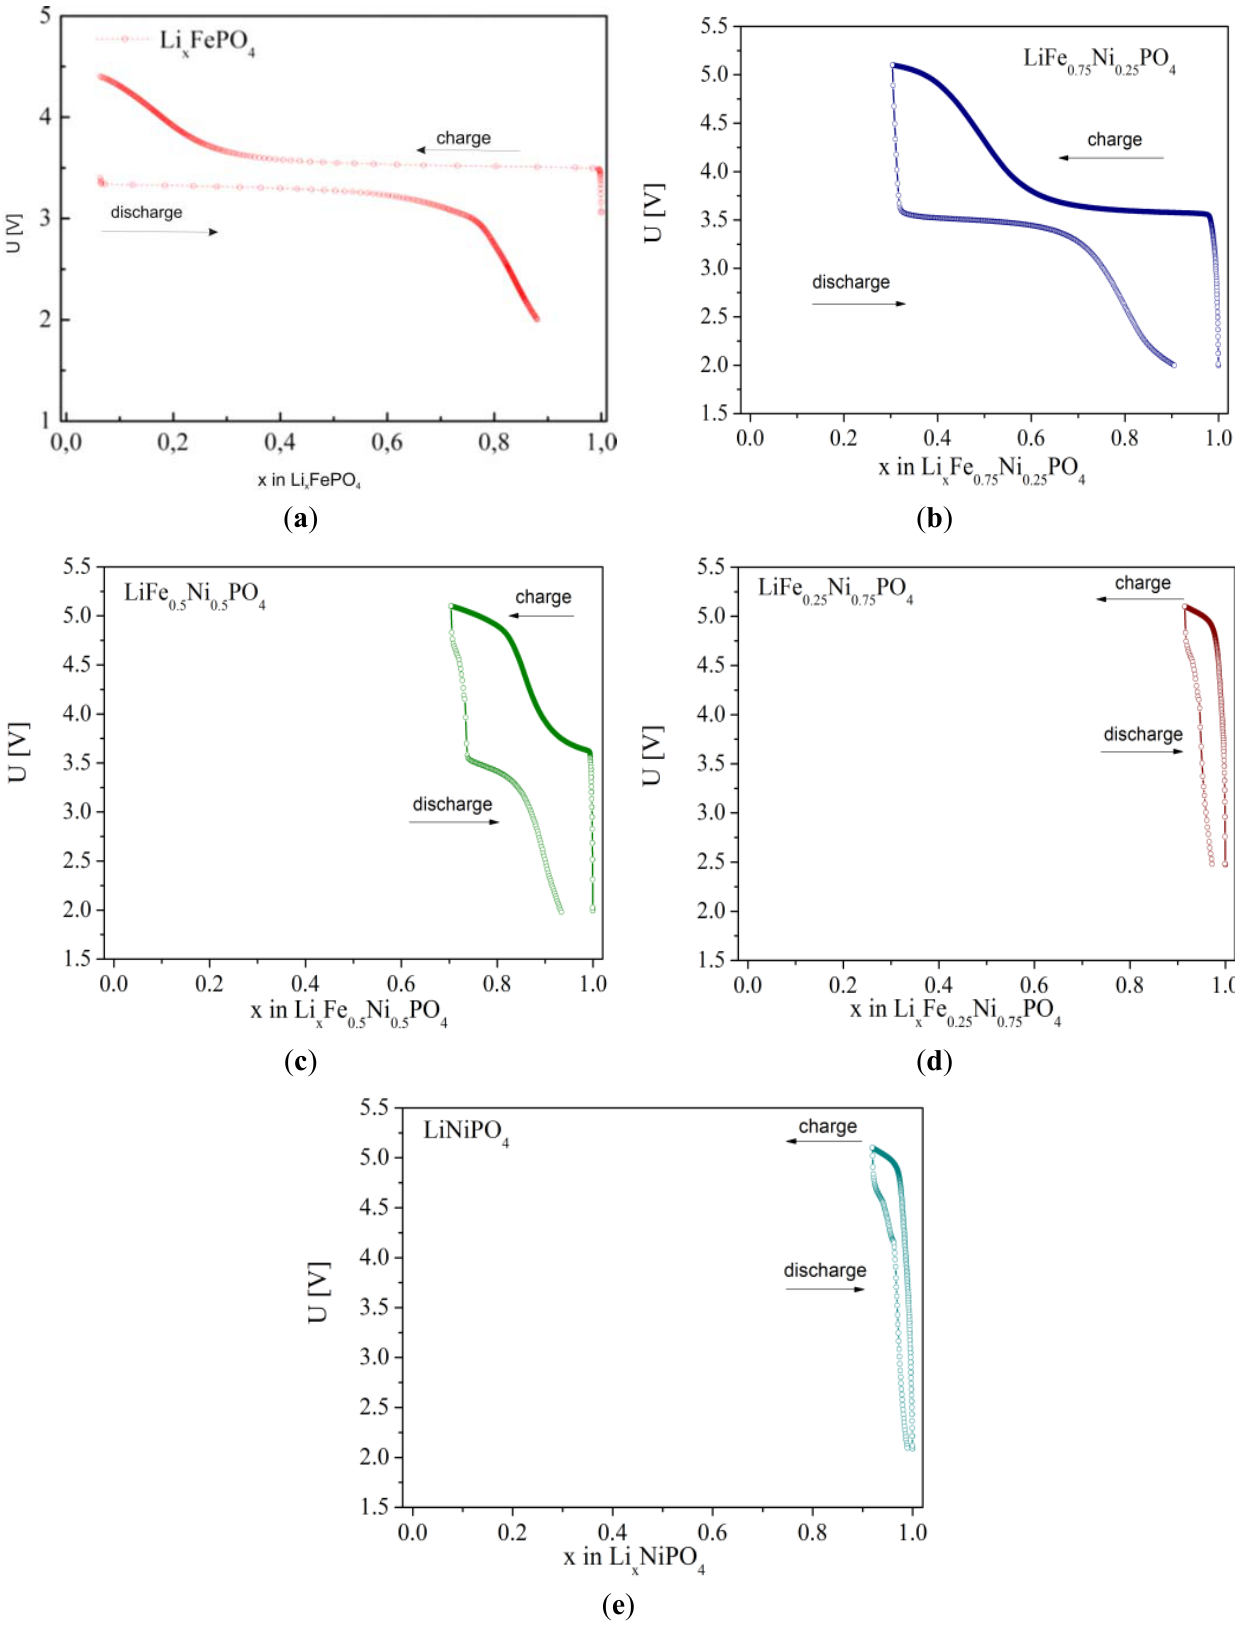
Figure 31. Charge/discharge curves for Li/Li + /Li speed for materials with: ( a ) y = 0; ( b ) y = 0.25; ( c ) y = 0.5; ( d ) y = 0.75 and ( e ) y =